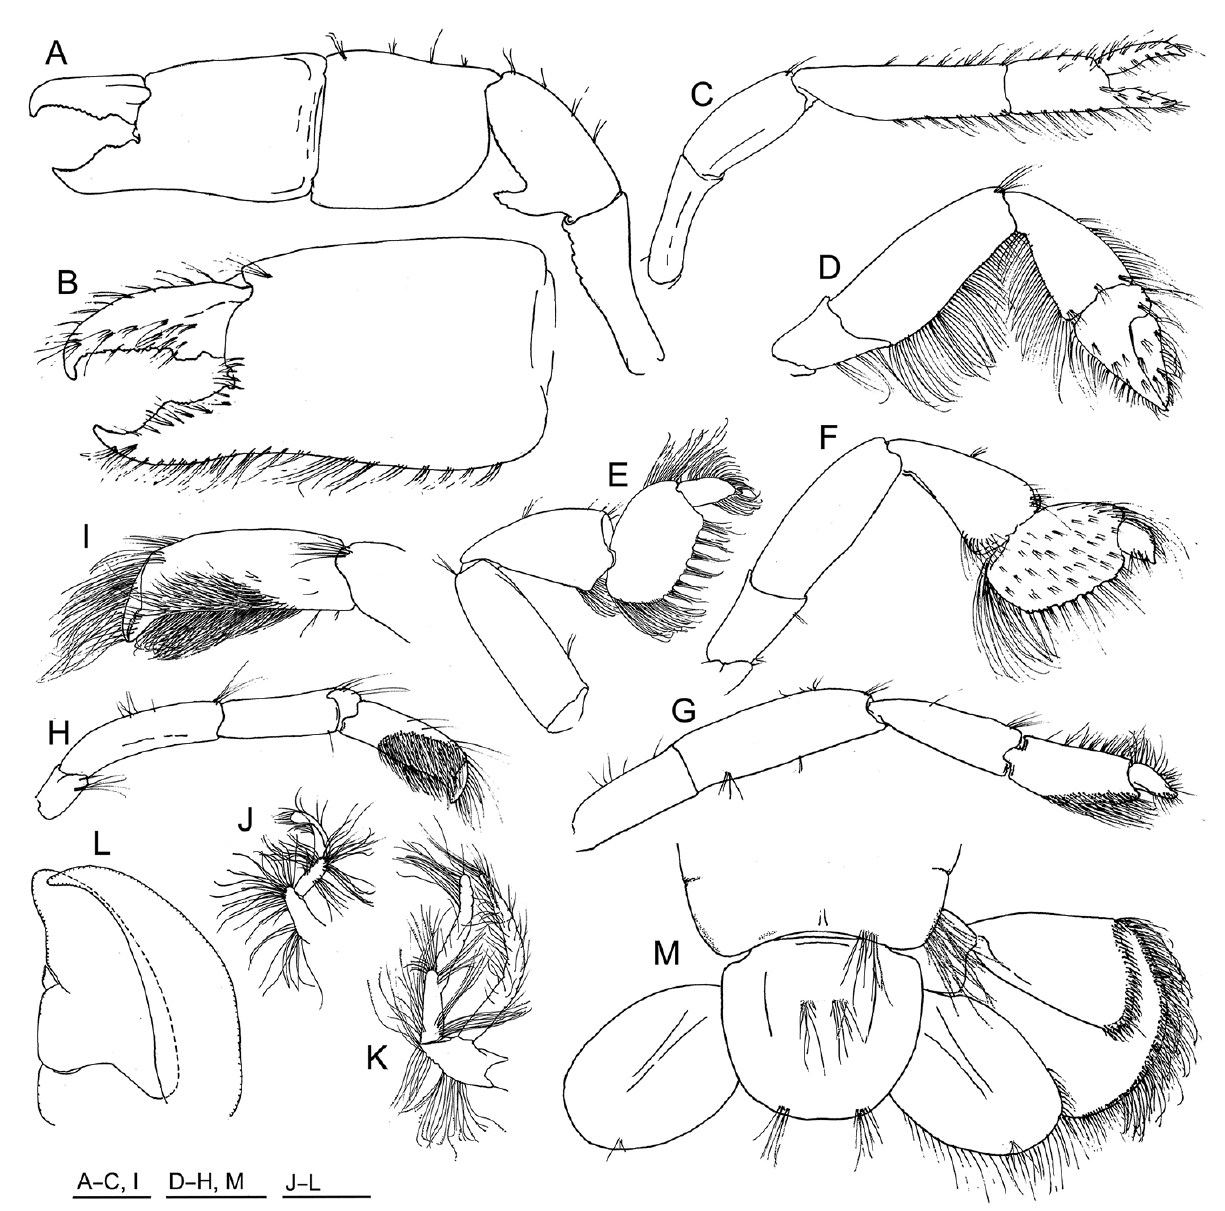
Figure 3. Gilvossius howellorum n. sp. A, E, J–L , ovigerous female paratype, pocl 11.5 mm, lower Tampa Bay, St. Petersburg, Florida, shallow subtidal flat (USNM 1540396 = ULLZ 4500TB-A); B–D, F–I, M , male holotype, pocl 12.4 mm, lower Tampa Bay, St. Petersburg, Florida, shallow subtidal flat (USNM 1546234 = ULLZ 12183). A , female major cheliped, external; B , male major chela, external; C , minor cheliped; D , right second pereopod, external; E , left third pereopod, internal; F , right third pereopod, external; G , left fourth pereopod, internal; H , right fifth pereopod, external; I , right fifth pereopod terminus, internal; J , female right first pleopod, external; K , female right second pleopod, external; L , right third pleopod, anterior; M , telson and uropods, dorsal, right uropodal setation shown. Scale bars = 3.0 mm ( A–H, J–M ), 1.5 mm ( I